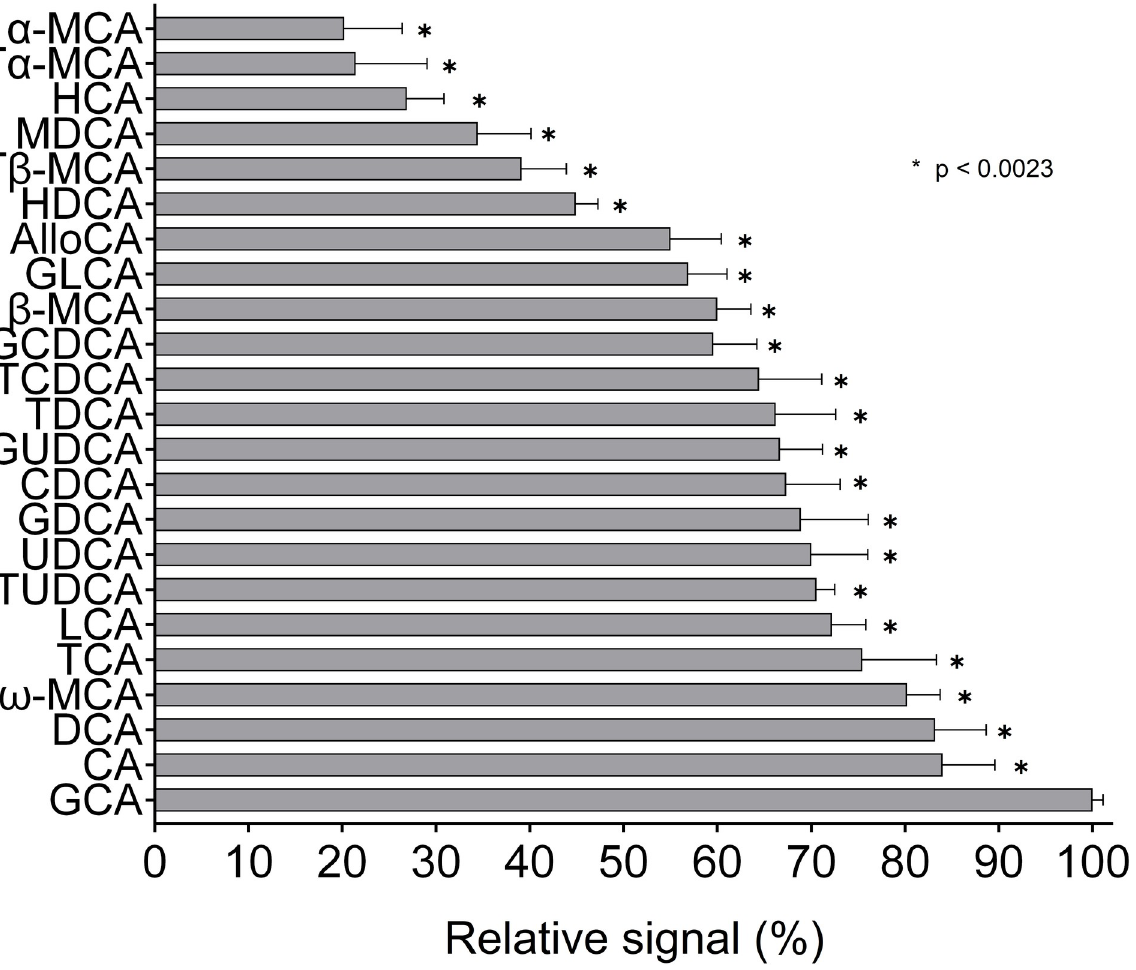
Fig 1. Relative signal intensities for individual BAs determined by an enzymatic method. Individual BAs were analyzed using an enzymatic kit, and the obtained signal was expressed as a % of the reference (GCA). Measurements were performed three times at three concentrations (20, 50, and 100 μ mol/L)—each bar thus represents the average of nine values. All values differ significantly from reference: p < 0.0023 (original p- value of < 0.0001 was adjusted for 23 comparisons using Bonferroni